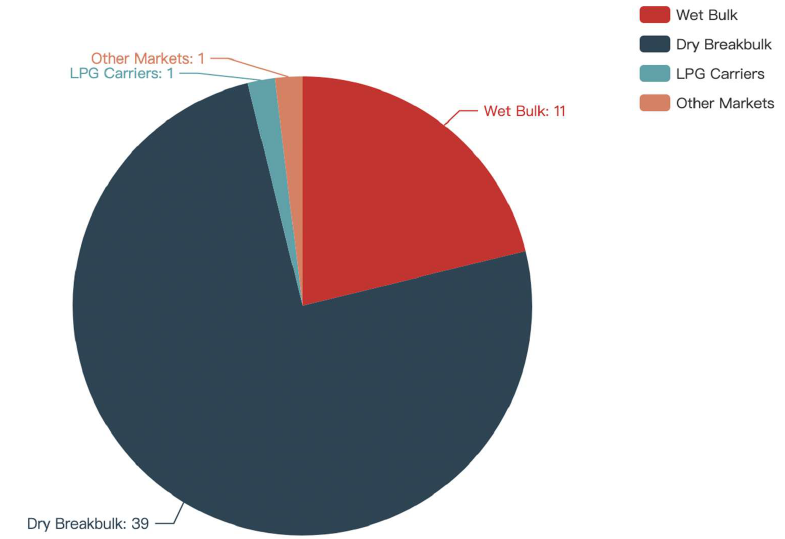
Figure 7. A pie chart of the ship types in Wuhan Port.